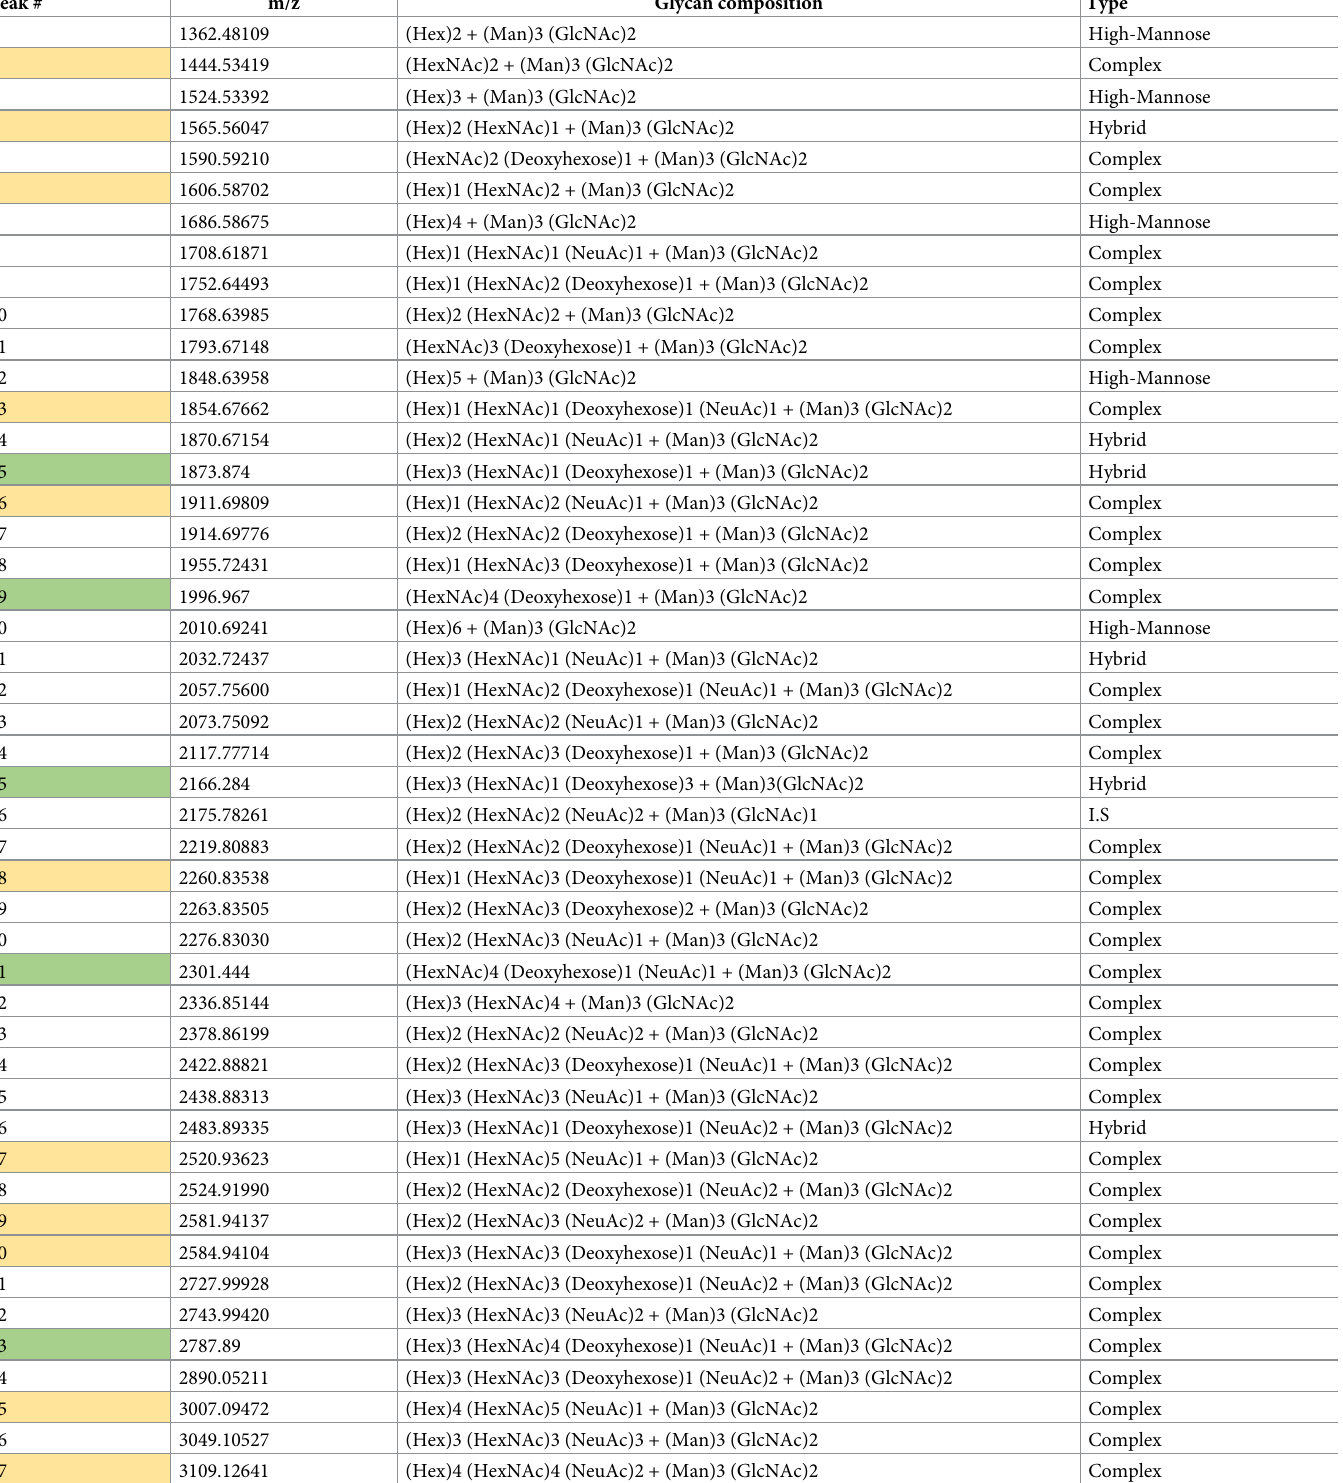
Table 1. Estimated composition of 51 N -linked glycans identified from human serum glycoproteins. Peak